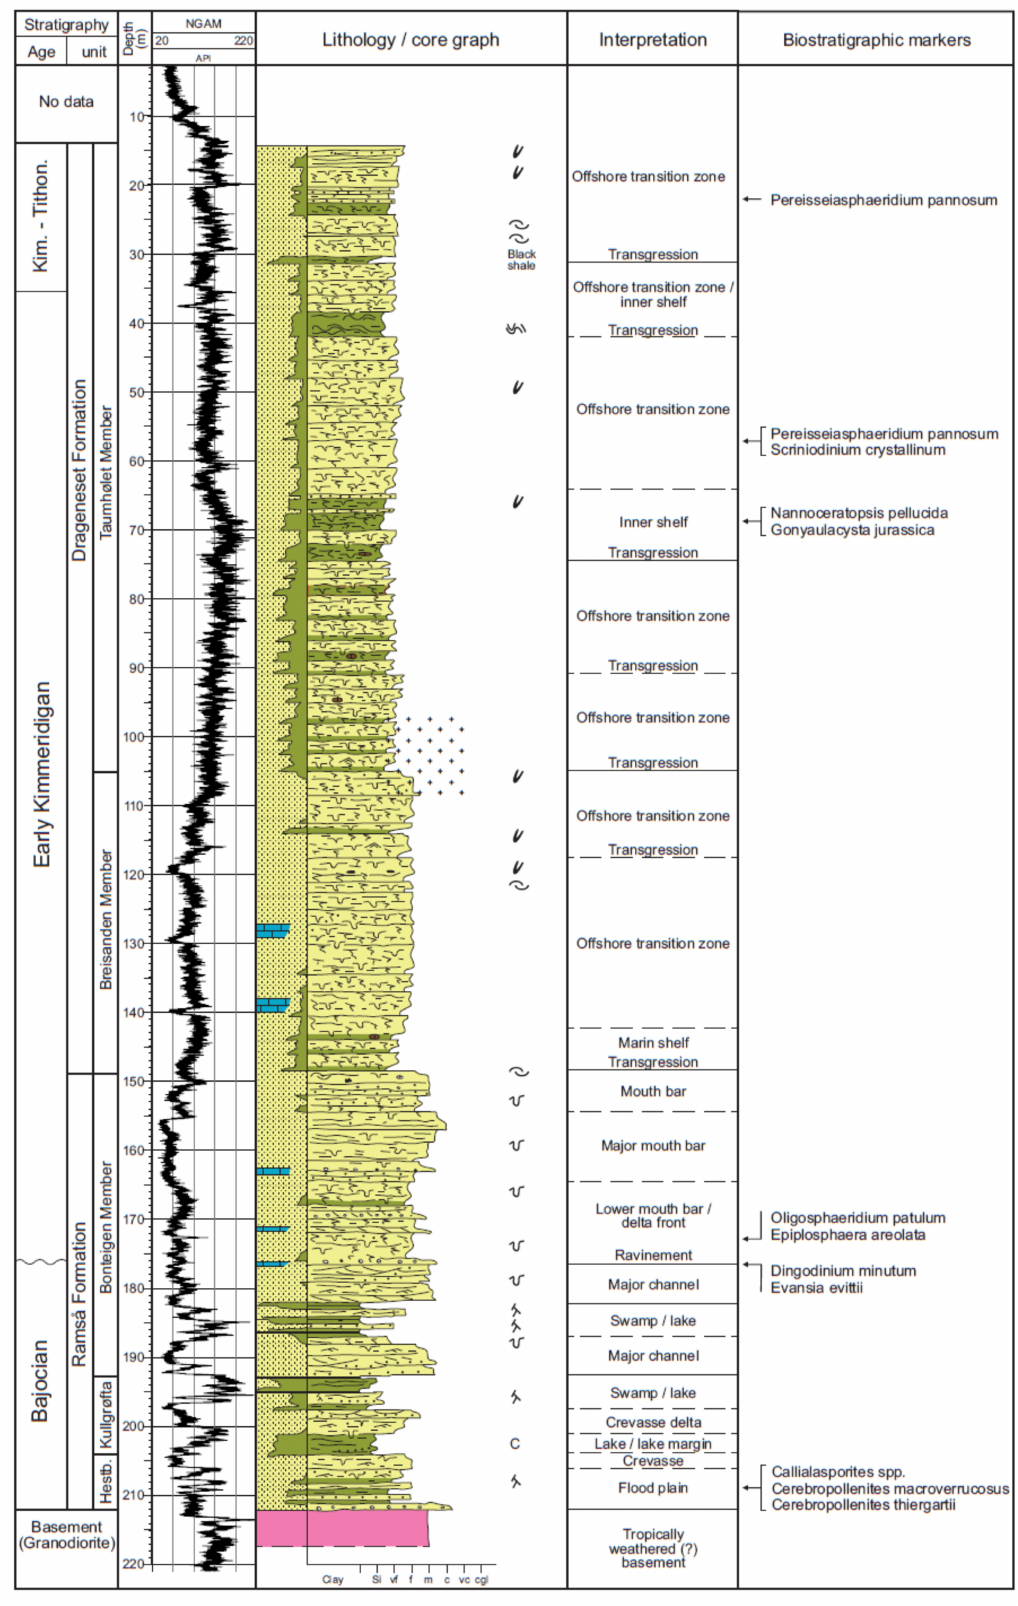
Figure 6. Lithological and gamma log of Bh 3, with interpretations of ages and depositional environments of the formations and members (Based on Bönner et al.